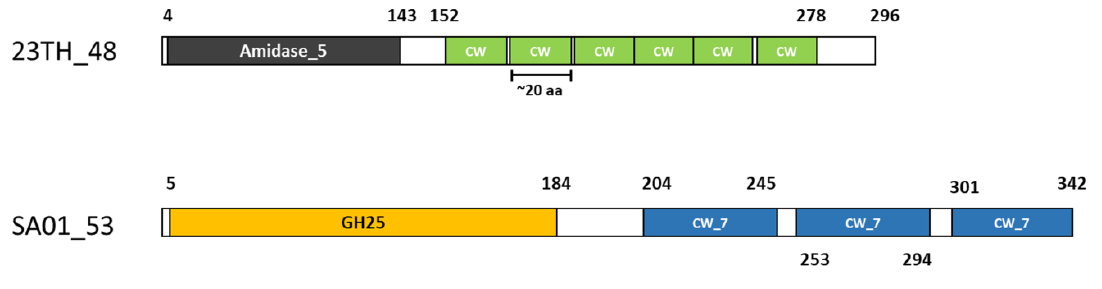
Figure 3. Lysin structures of 23TH_48 and SA01_53 as predicted with Pfam. Amidase 5 ( N -acetylmuramoyl-L-alanine amidase, PF05382), CW (CW-binding-1, PF01473), Choline cell wall binding domain), GH25 (Glycoside hydrolase family 25 subfamily, PF01183) and CW_7 (CW_7 repeat, substrate binding domain, PF08230). Differences in domains are indicated by different colors.